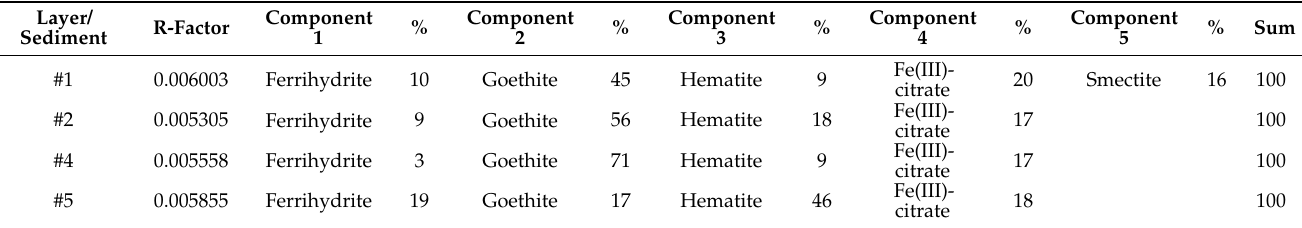
Table 3. Results for LCF performed on the k 3 -weighted Fe K-edge EXAFS data. Results are expressed in percentage of the fitting components corresponding to experimental spectra of model compounds.